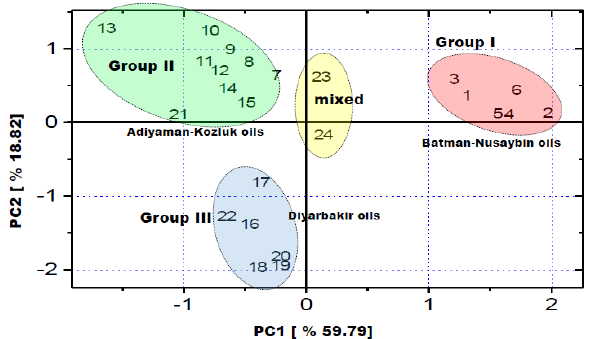
Figure 4. A score plot showing the genetic groupings between the SE-Turkey oils. Notice that PC1 and PC2 together carry the 78.61 % variance of the total data matrix. Numbers from 1 to 24 correspond the oil field/sample numbers in